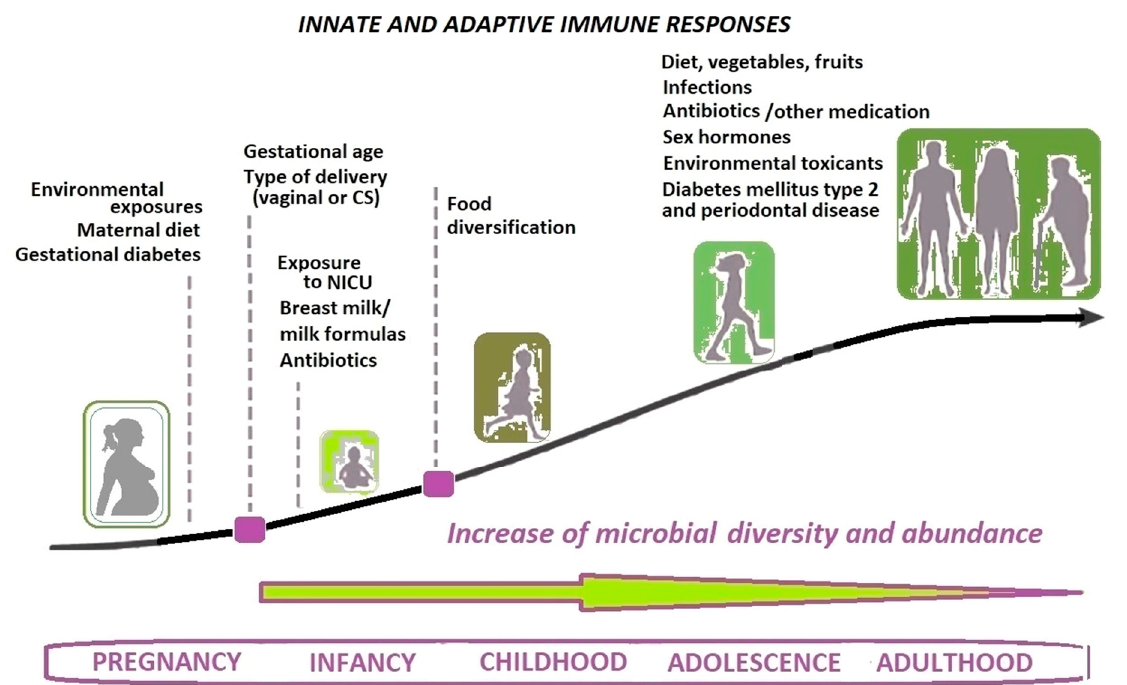
Figure 1. The main factors influencing the evolvement of human microbiome over the lifespan (adapted after [5,6,13]). NICU—neonatal intensive care unit; CS—cesarean